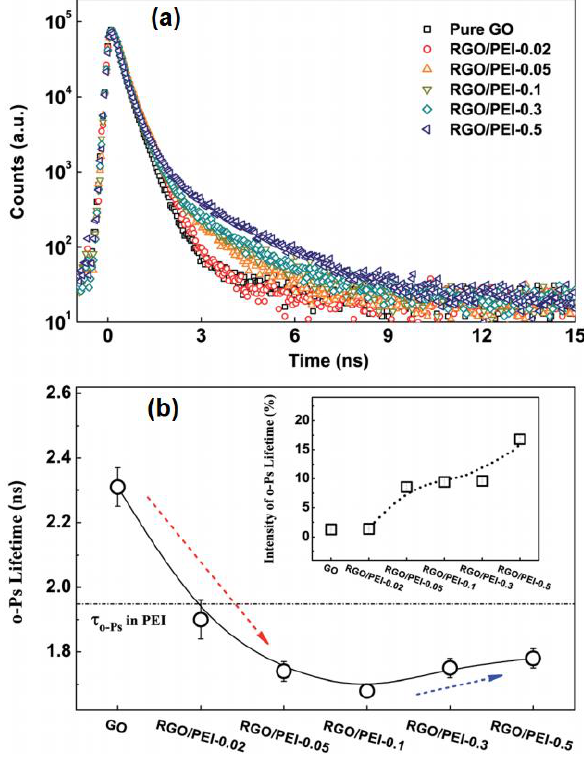
Figure 1. ( a ) The raw PALS spectra of PEI/RGO; ( b ) the variations in o-Ps lifetime and the intensity in the PEI/RGO composite film [44].